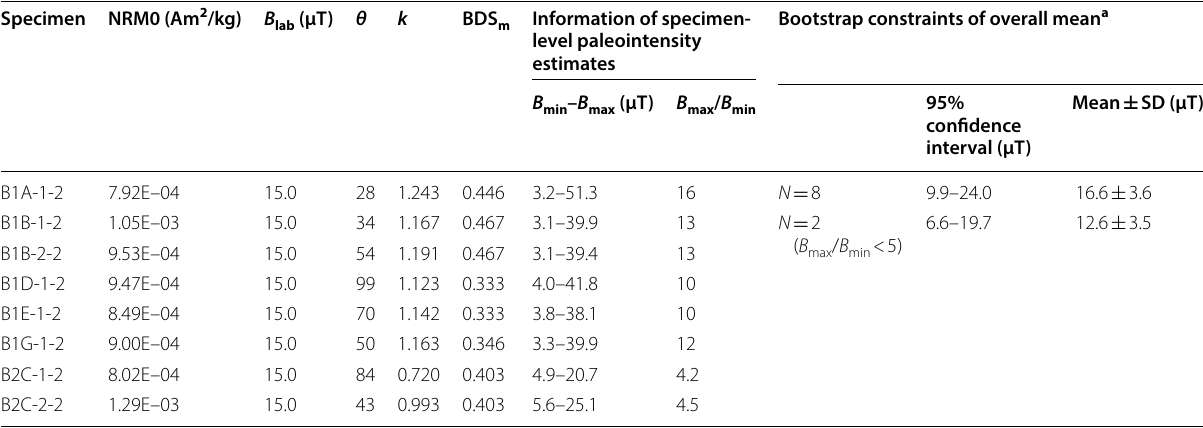
NRM0, B lab , θ, and k are the same as in Table 3. BDS m , the associated mean value from the measurements of bulk domain stability (Paterson et al. 2017) by 4 subsamples for the drilled samples. B min , B max , the minimum and maximum of all of PI estimates that meet a loose set of selection criteria (n Paterson et al. (2014) for definitions of the statistics) for each specimen a Describes the information on an overall mean of API estimates obtained when running a re-sampling routine that randomly picks values from the B each specimen and calculates a large number of their means ( n of the 10,000 means. See “IZZI-Thellier (IZZI-T) determination” section for details